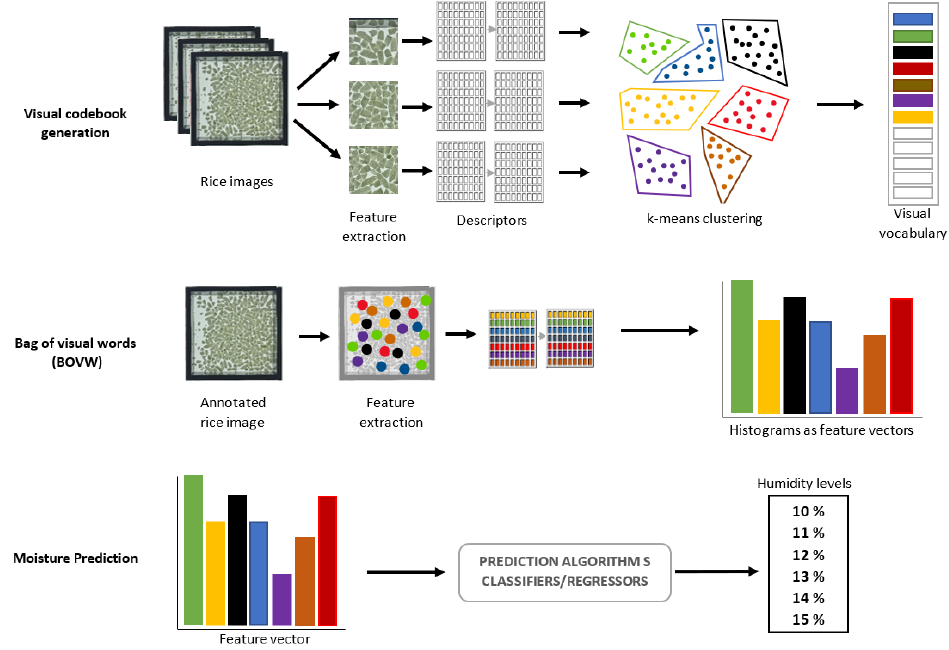
Figure 4. Scheme for the generation of visual words, the process of representing its frequency (BoVW), and the training of a classifier.